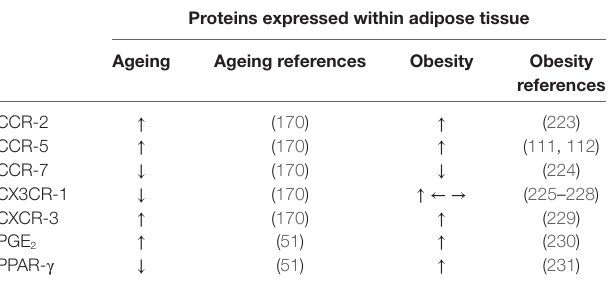
TABLe 3 | A comparison of the change in abundance for select immune cell subsets within adipose tissue with age and obesity compared to young and lean,